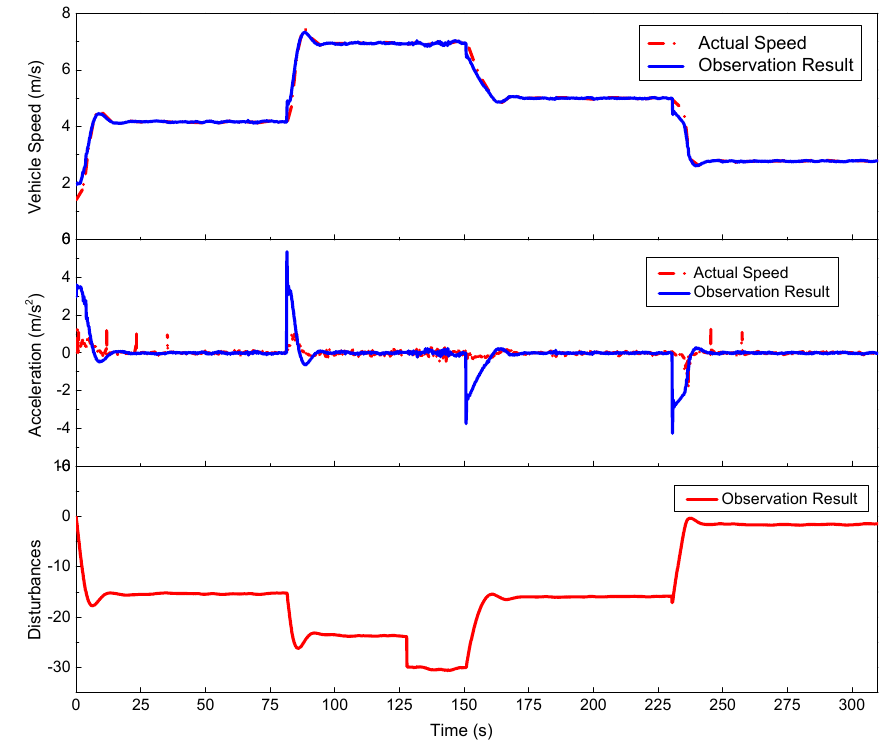
Figure 19. Observations made by extended state observer.